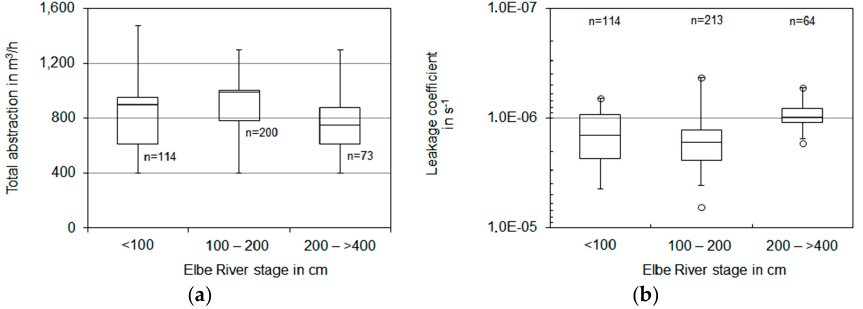
Figure 6. Comparison of river stage against ( a ) total abstraction; ( b ) leakage coefficient at transect II.